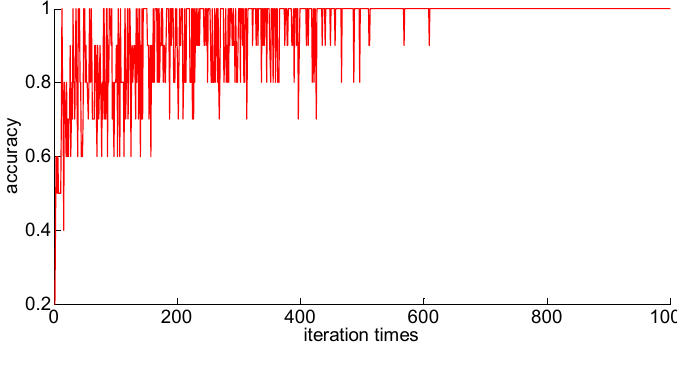
Figure 15. Fifty training samples of the neural network. Algorithms 2018 , 11 , x FOR PEER REVIEW